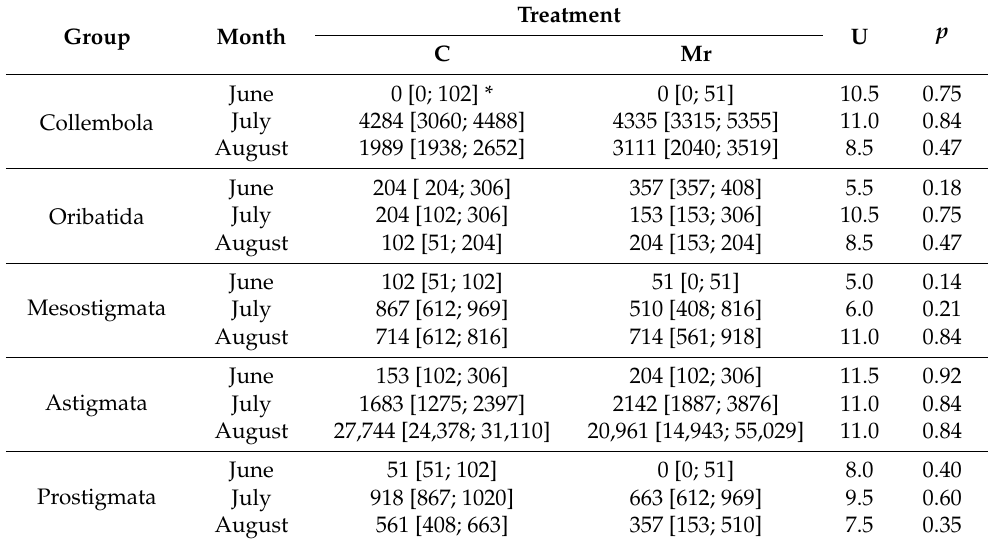
Table 3. Results of comparative analysis of the density of soil microarthropods (ind./m 2 ) in the plots with different types of seed treatment in 2020 (Mann–Whitney test).